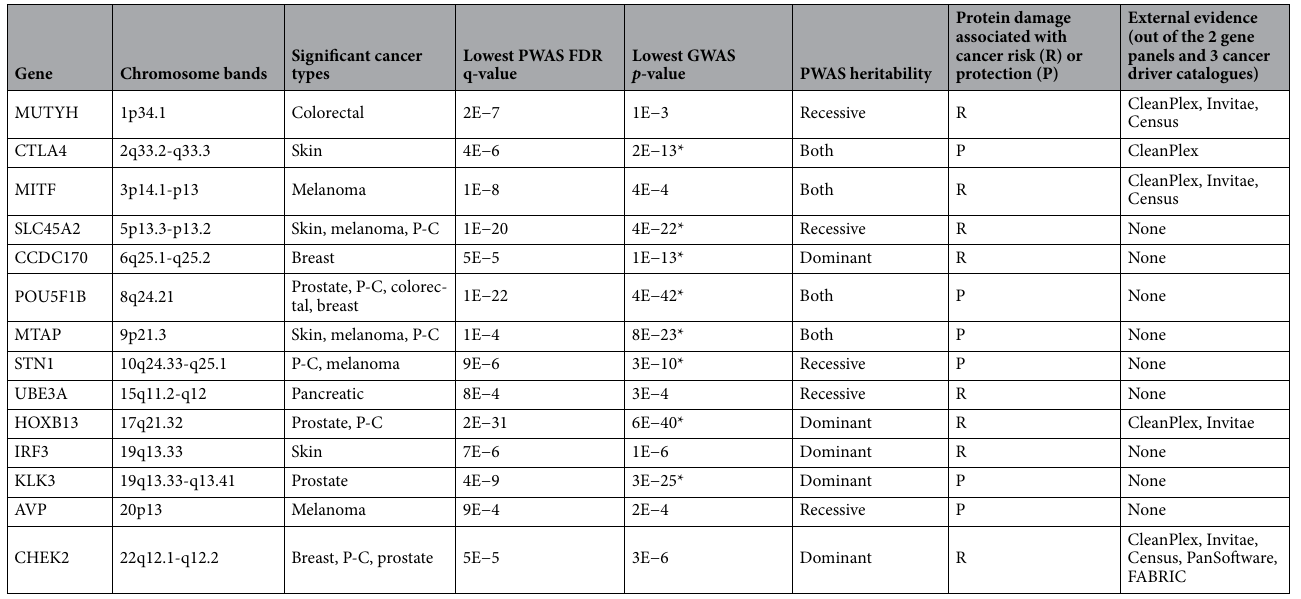
Table 1. Soliton cancer genes discovered by PWAS. *Below the GWAS exome-wide significance threshold (5E−07); P-C,